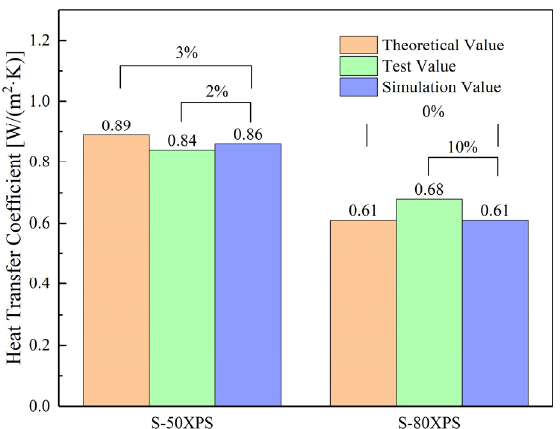
Figure 19. Comparison of test, theoretical, and simulation values.